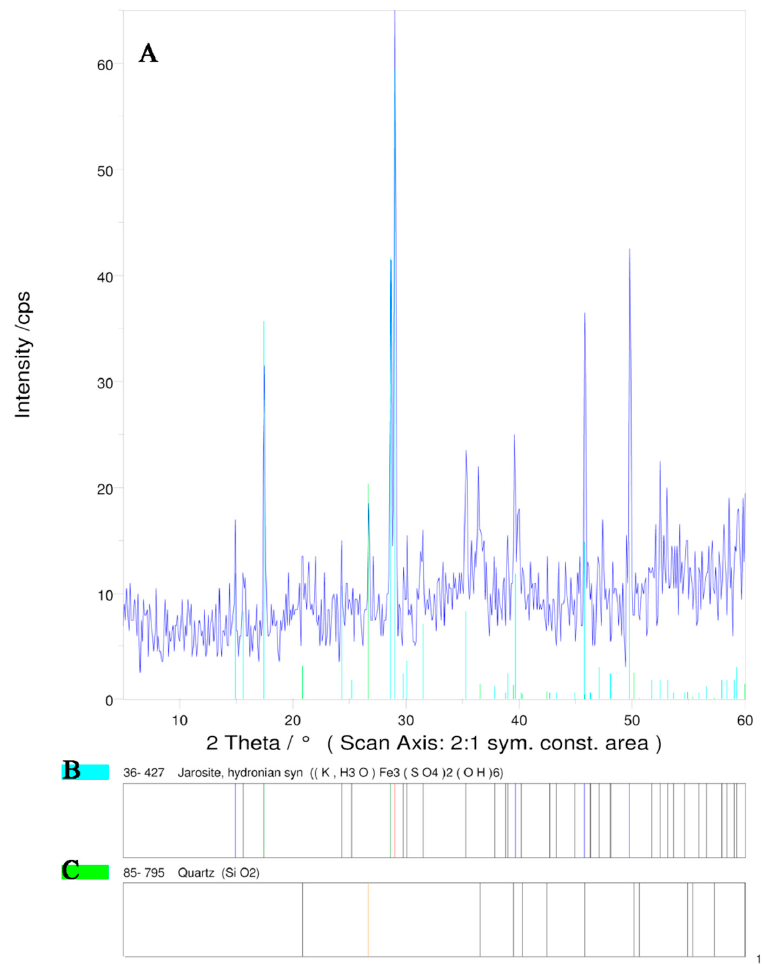
Figure 2. XRD analysis. ( A ) XRD pattern of the deposits sampled in M13 sampling site; ( B ) XRD pattern of hydronium jarosite syn; ( C ) Quartz XRD pattern.